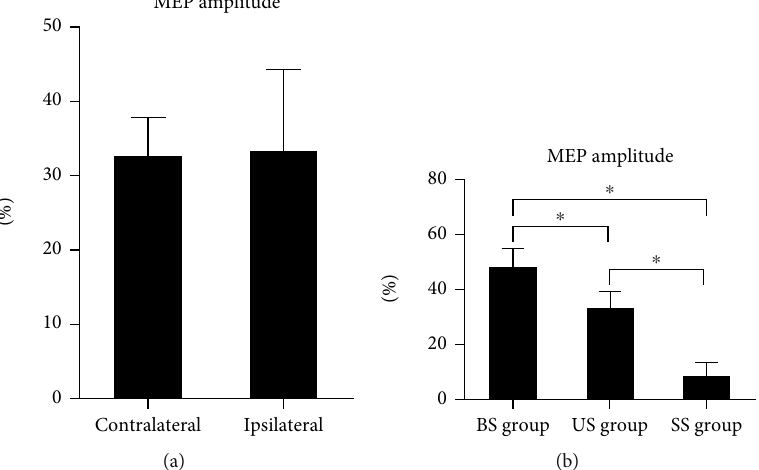
Figure 7: Changes in MEP amplitude in the motor area of the suprahyoid muscle group in the cerebral cortex after treatment. BS group: bilateral stimulation group; US group: unilateral stimulation group; SS group: sham stimulation group; MEP: motor evoked potential. (a) In the US group, the increase in MEP amplitude in the contralateral cerebral cortex (relative to the dominant cerebellum) was not di ff erent from that in the ipsilateral cerebral cortex (relative to the dominant cerebellum). (b) The increase in the MEP amplitude of the cerebral hemisphere in the BS group was higher than that in the other two groups, and the increase in MEP amplitude in the US group was higher than that in the SS group. ∗ P < 0 : 05